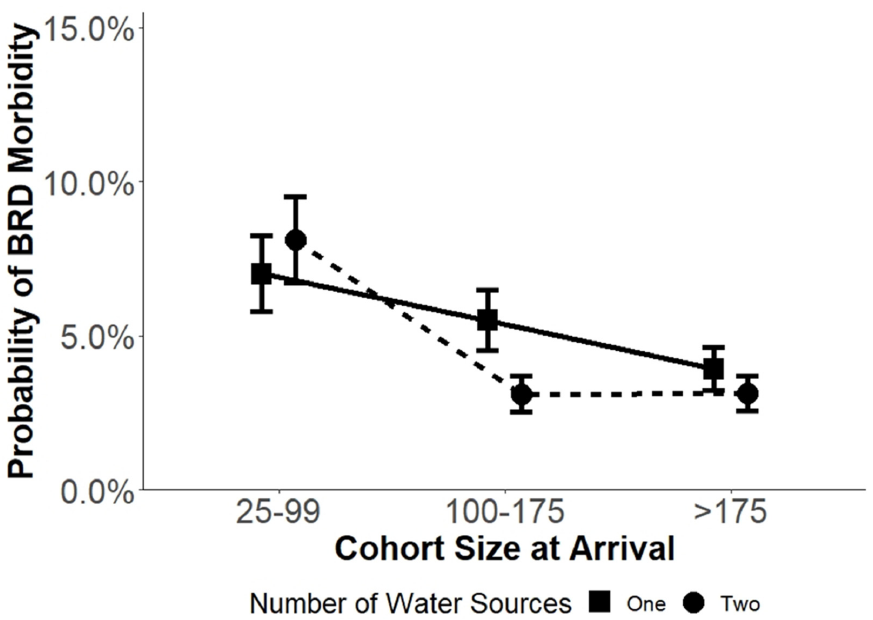
Figure 2. Model estimated mean probability of BRD incidence by total water sources and cohort size at arrival category in commercial feedlot cattle from 10 United States feedlots during the first 45 DOF using the NWmod *. Error bars represent SE of the probability. * NWmod is a generalized mixed model evaluating the number of water sources while including covariates for cohort sex, size at arrival, average arrival weight, arrival quarter and significant